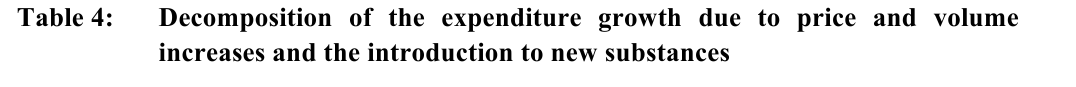
Decomposition of the expenditure growth due to price and volume increases and the introduction to new